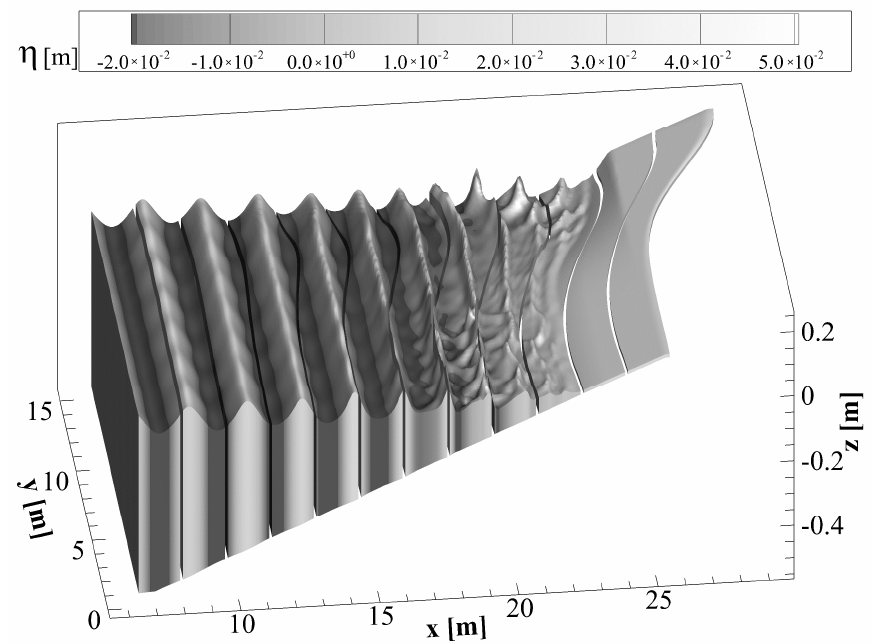
Figure 9. Test 4. Rip current. Instantaneous view of the wave field obtained using the proposed WTENO model. WTENO